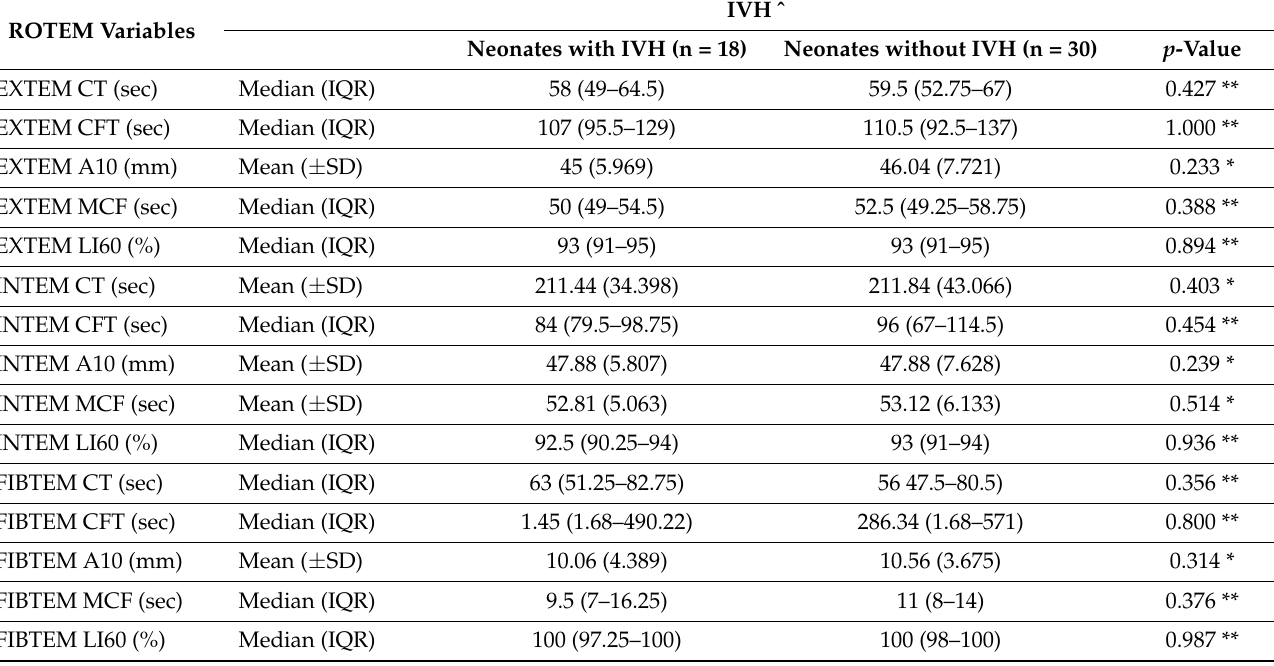
Table 7. ROTEM variables in neonates with RDS in correlation to